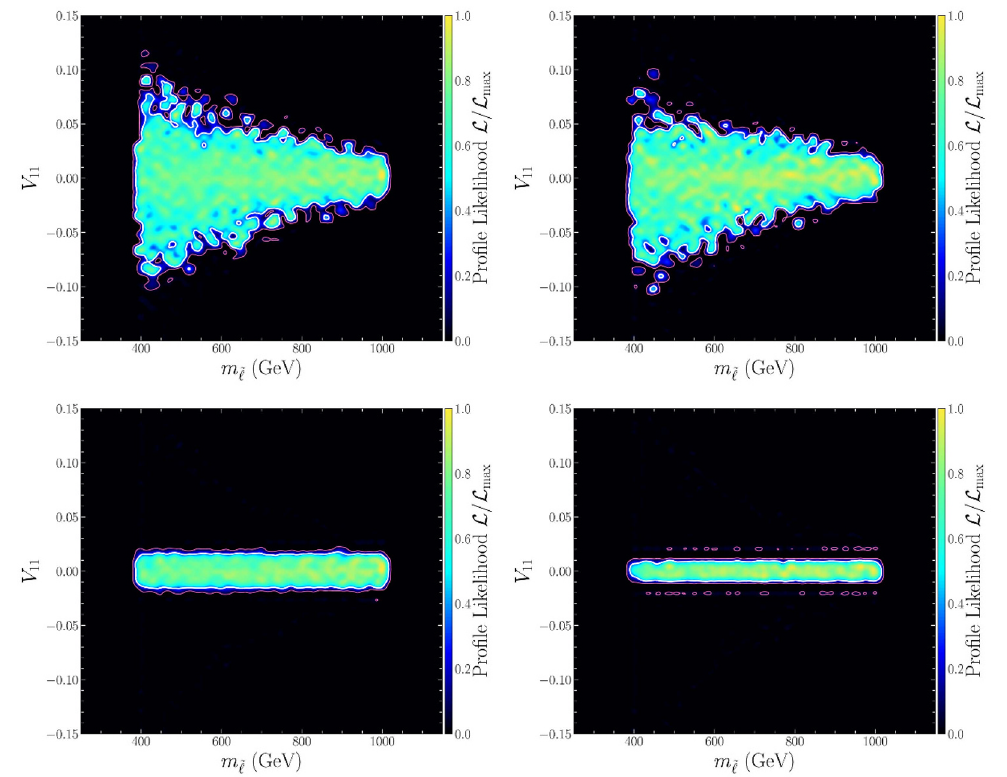
Figure 5 . Same as figure 1, but for the profile likelihood projected onto V 11 − m ˜